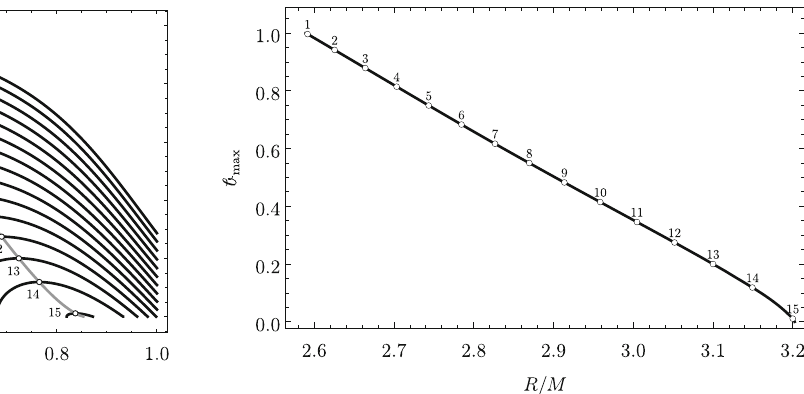
Fig. 7 Thelocaltrappingefficiencyradialprofile b ( r , C ) illustratedfor several values of inverse compactness R / M of the extremely compact Tolman VII spacetimes (left plot). The parameter R / M for each curve